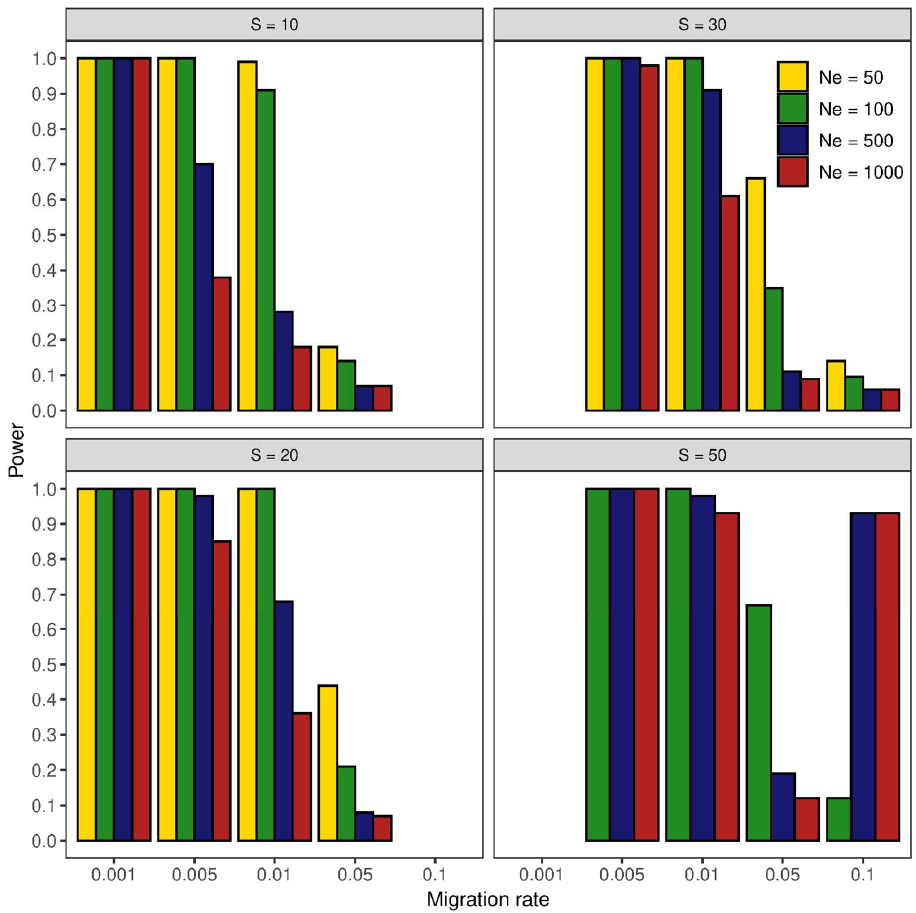
Figure 4. Sample size effect on the power of detecting population differentiation under different N e m values. Scenarios were simulated by combining different sample sizes ( S ), effective population sizes ( N e ), and migration rates ( m ) under a simple symmetric finite island model of gene flow. The power of detecting genetic differentiation was assessed by computing the proportion of successful detections over 1000 iterations for each scenario.